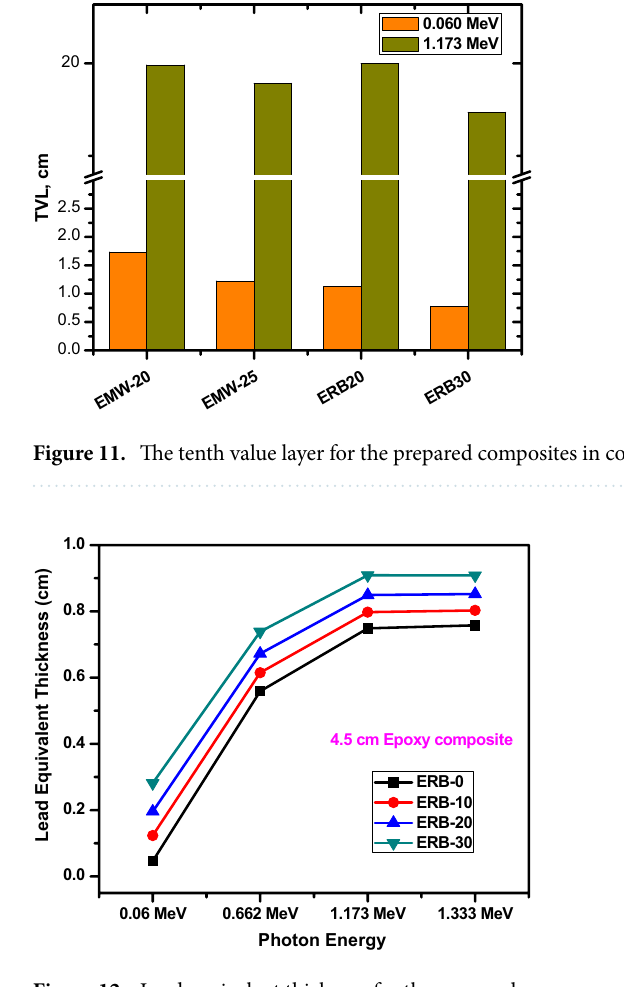
Figure 12. Lead equivalent thickness for the prepared epoxy